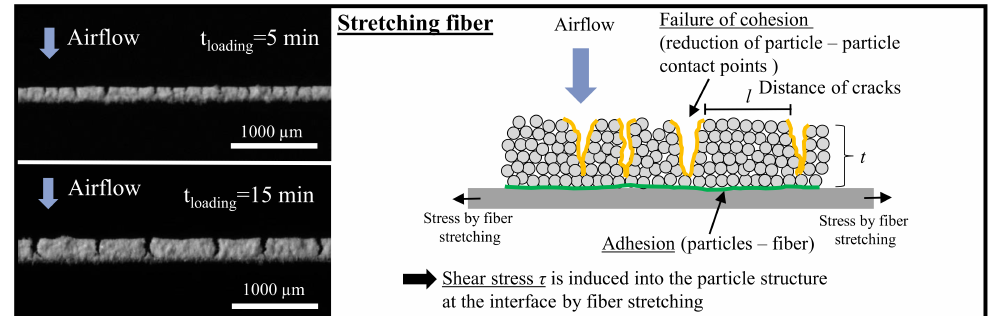
Figure 8. ( LEFT ): Images (side view) of the loaded fiber after 5min loading time (TOP) and after 15min loading time (BOTTOM) at 8% fiber elongation during the first stretching cycle. Same elongation velocity of 0.6mm s − 1 . Illumination of the structure from the front. ( RIGHT ): Schematic of the loaded fiber in the stretched state. Marked the physical state of the interfacial